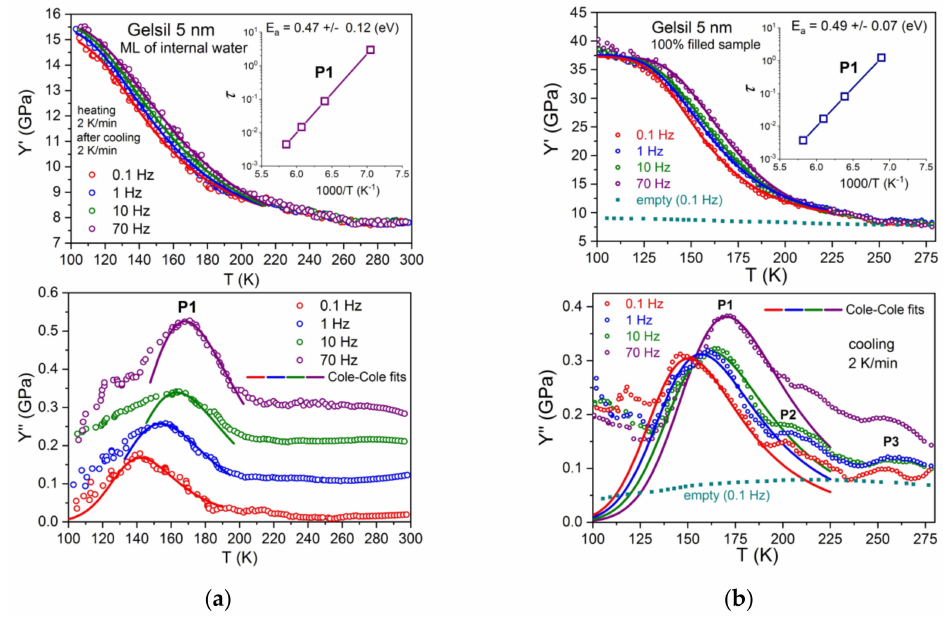
Figure 4. Temperature dependencies of Y (cid:48) and Y (cid:48)(cid:48) at various frequencies: ( a ) partly filled samples (ML) of Gelsil 5 nm. ( b ) fully filled samples. The insets show Arrhenius plots corresponding to P1, yielding identical (within error bars) activation energies for samples partially and fully filled with water. Note, that the freezing / melting peak P3 does not shift with frequency. Y” data are shifted upwards to avoid overlapping of the data. Full lines are Cole-Cole fits using Equations (1) and